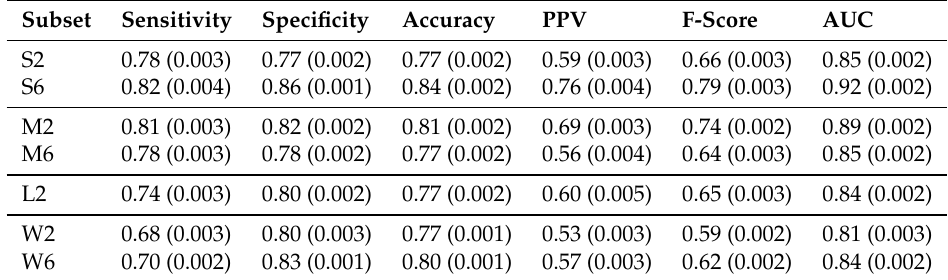
Table A7. Predictive performance of neural network based on the estimated sensitivity, specificity, accuracy, positive predictive value (PPV), F-score and the area under receiver operating characteristic curve (AUC) for two-week and six-week restriction period among the cows in early (S), mid (M) and late (L) lactation stage using cross validation studies.